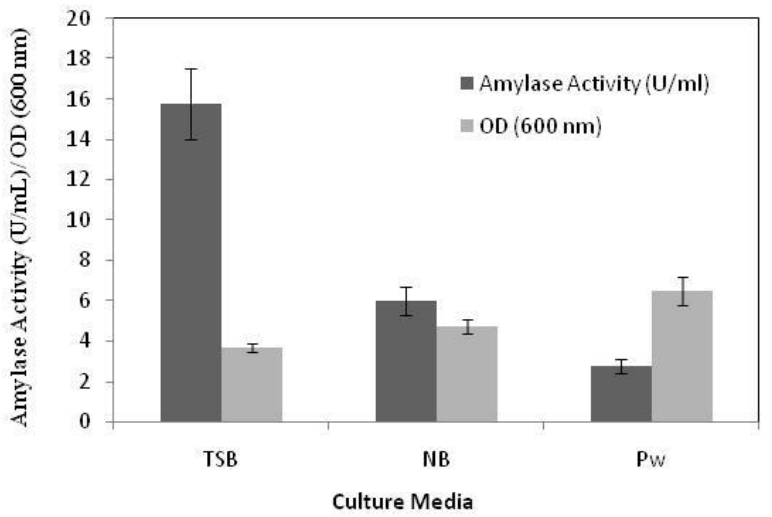
Figure 1. Effect of culture media on Bacillus pacificus growth ( OD600 ) and amylase activity (U/mL). Starch soluble in 250 mL flasks were incubated with 1 mL of bacterial overnight culture (2 × 10 6 CFU/mL) at 37 ◦ C for 48